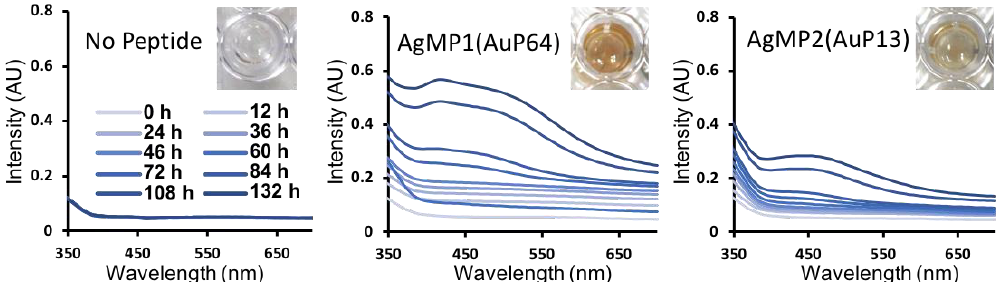
Figure 3. Time-dependent changes in absorption spectra of silver nanoparticles (AgNPs) synthesized by screened peptides, including AgMP1(AuP64) and AgMP2(AuP13). The mineralization was monitored until 132 h in the presence of each mineralization peptide (5 mM) and AgNO 3 (50 mM). Images of solutions containing AgNPs synthesized by each peptide at 132 h are included.